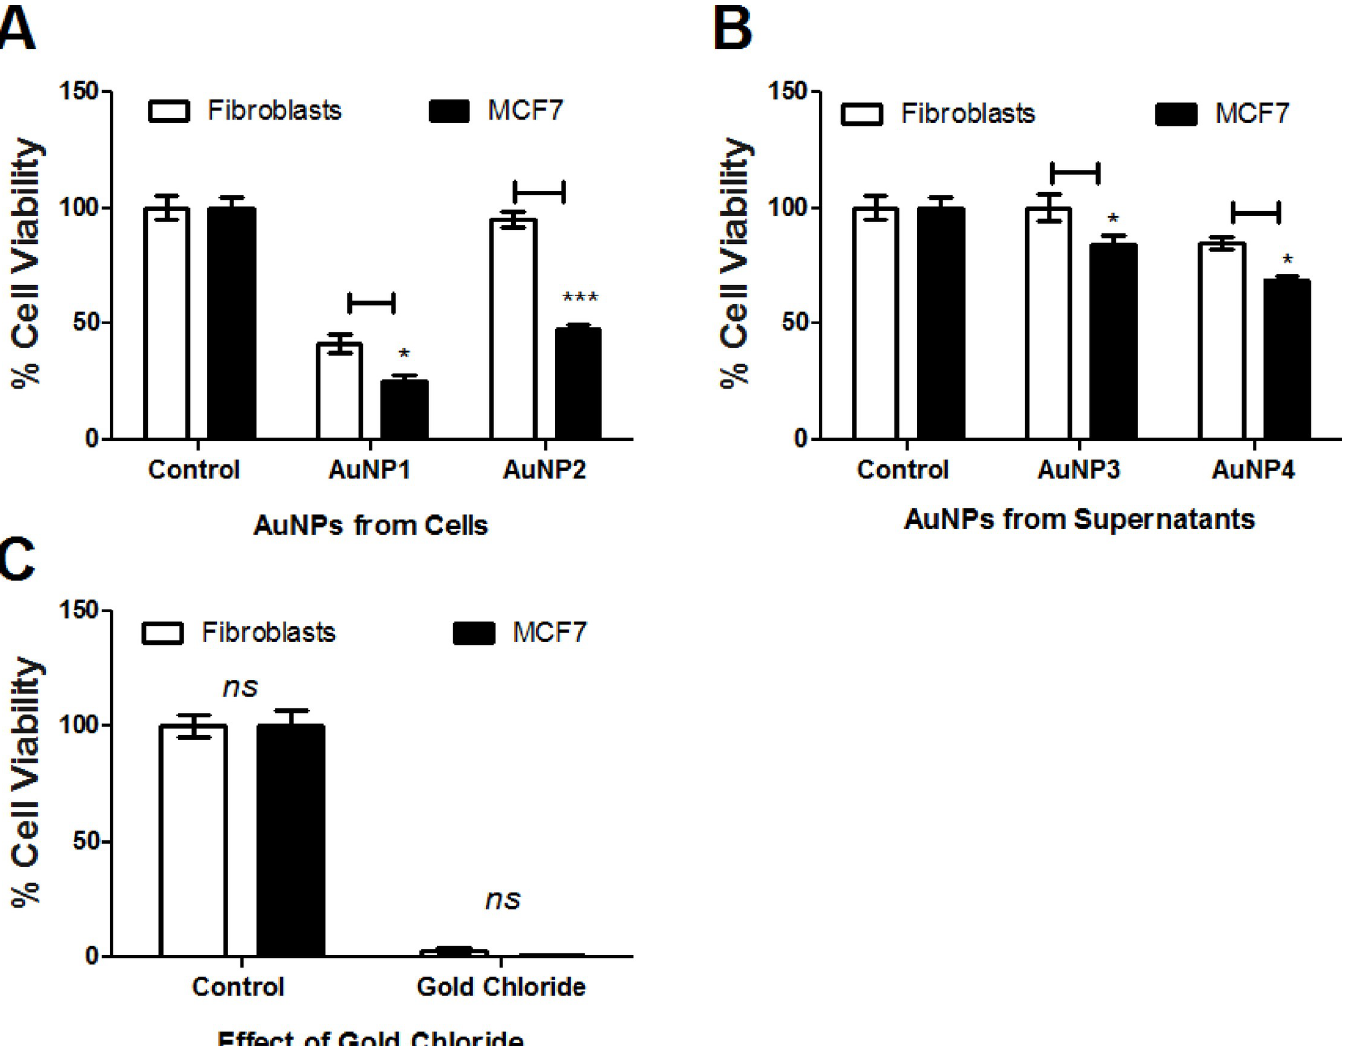
Fig 5. Cytotoxic activities of AuNPs developed from metabolites extracted from (A) mammalian cells (F180: AuNP1 and MCF7: AuNP2) versus (B) cells-free supernatants (AuNP3 and AuNP4) compared to (C) Gold Chloride effect. The cells were seeded in 96-well plate until confluency followed by incubation with the samples overnight prior to MTT assay. The data was analyzed using two-way ANOVA and statistical significance was calculated with Bonferroni’s multiple comparisons test and significance levels were indicated by asterisks ( � , P < 0.05; �� , P < 0.01: ��� , P < 0.001; ���� , P < 0.0001). The data display the mean of the percentage of the survival rate of mammalian cells ± SEM of 6